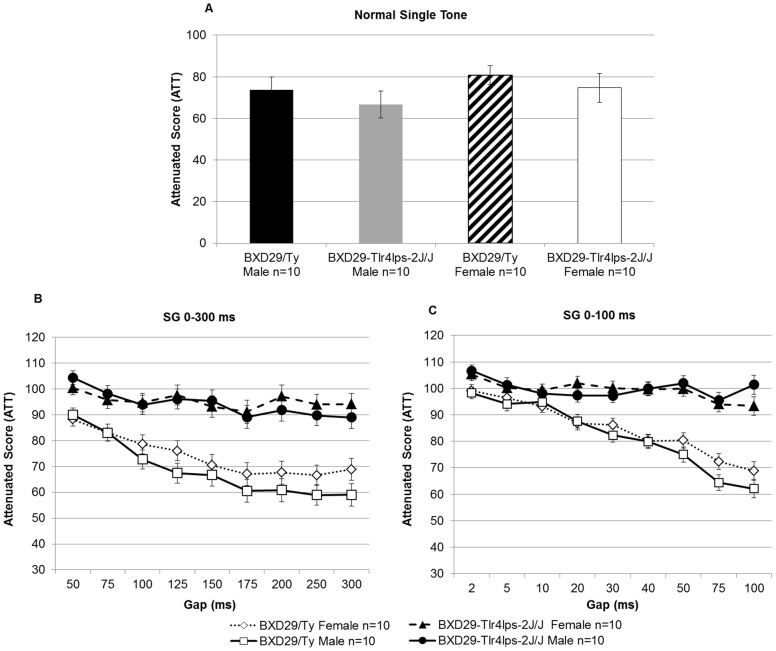
Auditory processing of BXD29-Tlr4lps−2J/J mutant and BXD29/Ty wildtype mice.A) Assessment of baseline auditory pre-pulse inhibition indicated comparable hearing and pre-pulse inhibition ability across Sex and Strain. Note, a lower attenuation score indicates better auditory pre-pulse inhibition ability. B) Silent Gap 0–300 ms and C) Silent Gap 0–100 ms gap detection tasks showed that BXD29-Tlr4lps−2J/J mutant mice were specifically impaired in rapid auditory processing. The lack of Sex × Strain interaction signified no sex differences in RAP across both tasks, suggesting that female BXD29-Tlr4lps−2J/J mutant mice did not exhibit a behavioral sparring of rapid auditory processing ability.